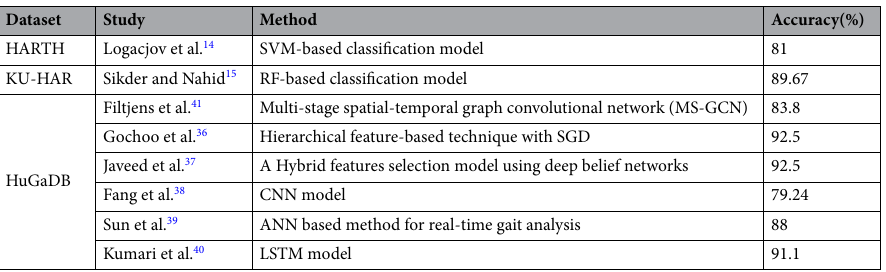
Table 1. A tabular summary of different HAR methodologies and their corresponding performances (in terms of accuracy) achieved till date for HARTH, KU-HAR and HuGaDB